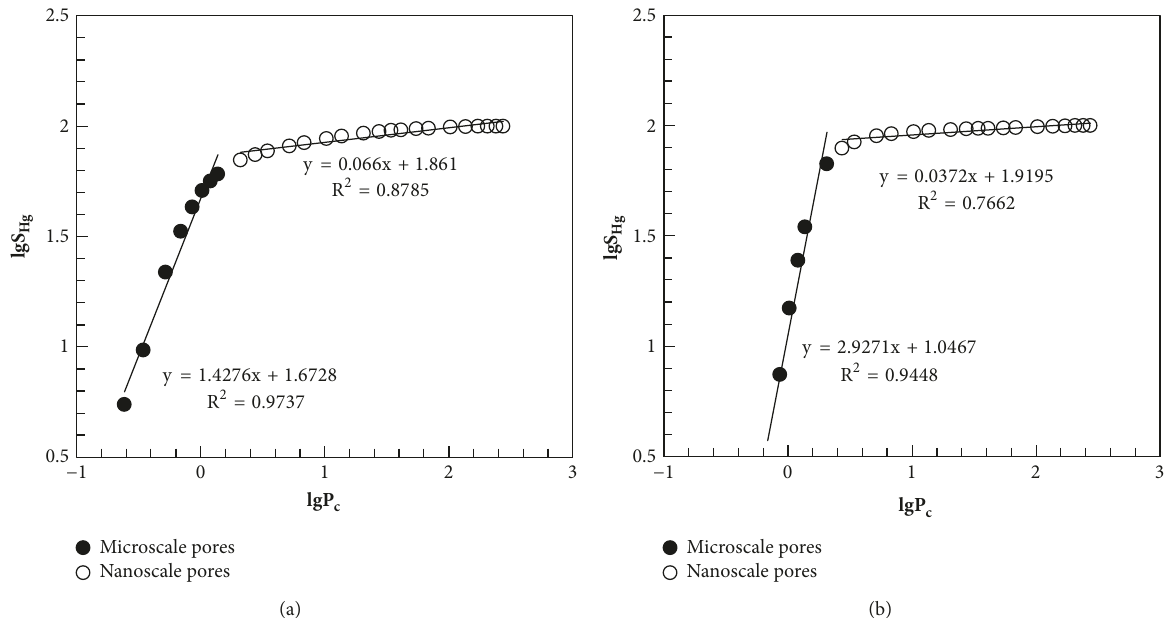
Figure 4: Fractal dimensions calculation for nano- and micropores with method II using two-straight-line fitting ((a) no. 2 core sample; (b) no. 6 core sample).